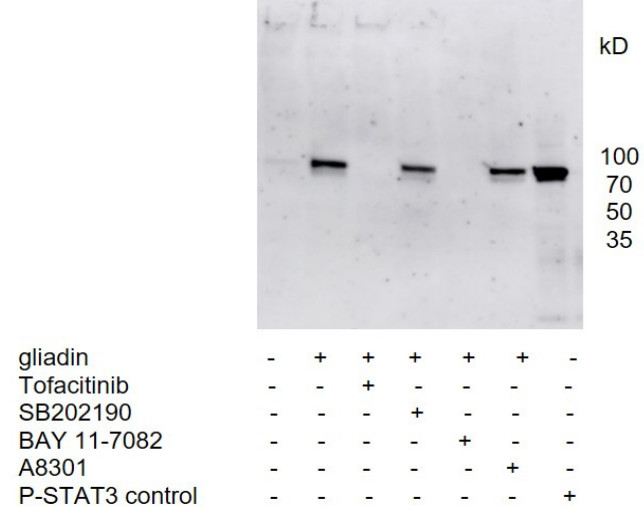
Figure 3. Western blot to detect P-STAT3 upregulation caused by gliadins. Preincubation of PBMCs for 1 h with Tofacitinib citrate. BAY 11-7082 prevented gliadin-induced P-STAT3 expression. No inhibition was noticed with SB202190 and A-8301. The P-STAT3 control protein is shown on the right lane. Experiments were performed twice for n = 3 healthy controls, and representative Western blot is shown.